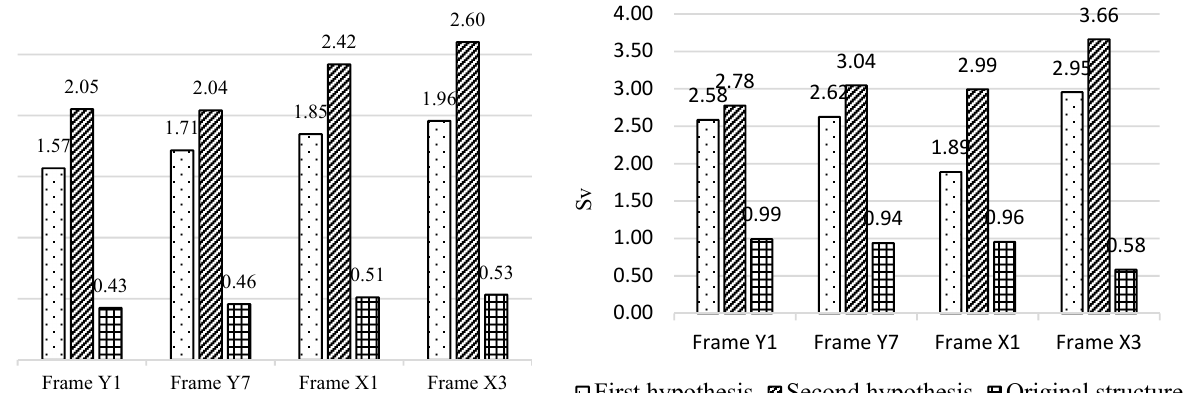
Figure 25. Histograms displaying risk indicators in terms of accelerations ( a ) and displacement ( b ) calculated for selected X and Y frames of the original structure, as well as for the first and second intervention hypotheses. Table 7. Local intervention technique with steel angles and batten plates—second hypothesis.